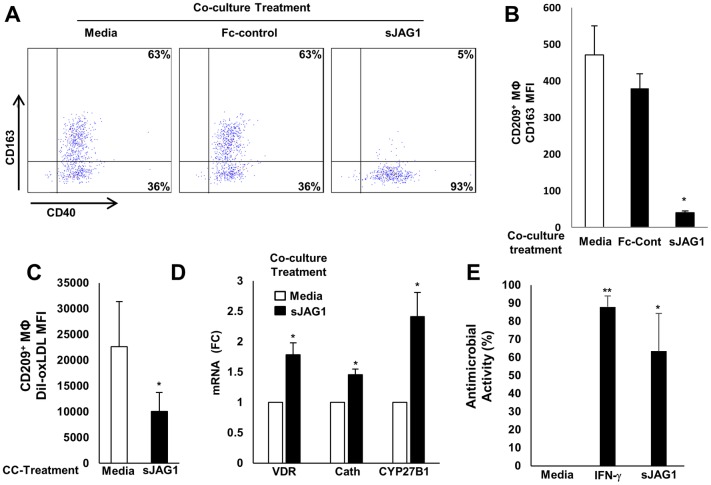
JAG1 facilitates antimicrobial CD209+MΦ differentiation.(A, B) JAG1 (250ng/ml) added to EC/primary mononuclear cell co-cultures (CC) promotes the antimicrobial CD209+MΦ phenotype (representative log scale dot plots, and mean +/- SEM of n = 6 experiments, * p value < 0.05). Functional characterization of MΦ as determined by (C) phagocytosis of Dil-oxLDL, (D) induction of the vitamin D pathway in CD14+MΦ and (E) antimicrobial ability. For antimicrobial ability determination, co-culture derived CD14+MΦ were infected with M. leprae (MOI 10:1) overnight. After infection, cells were treated with IFN-γ and supplemented with 25-D3 for a period of five days. Determination of M. leprae viability was calculated using the ratio of bacterial 16S RNA and DNA (RLEP) as quantified by qPCR. Data represent the mean +/- SEM from at least three independent donors (* p value < 0.05, * * p value < 0.01).